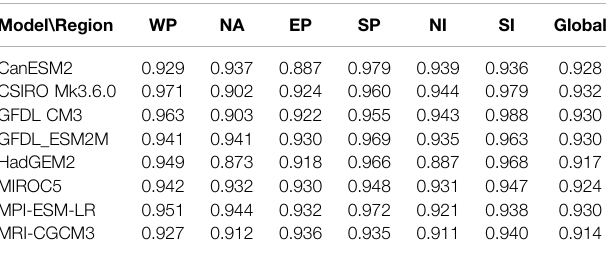
TABLE 3 | Index of monthly variation of TC frequency proportion for eight CMIP5 models in different areas and globe